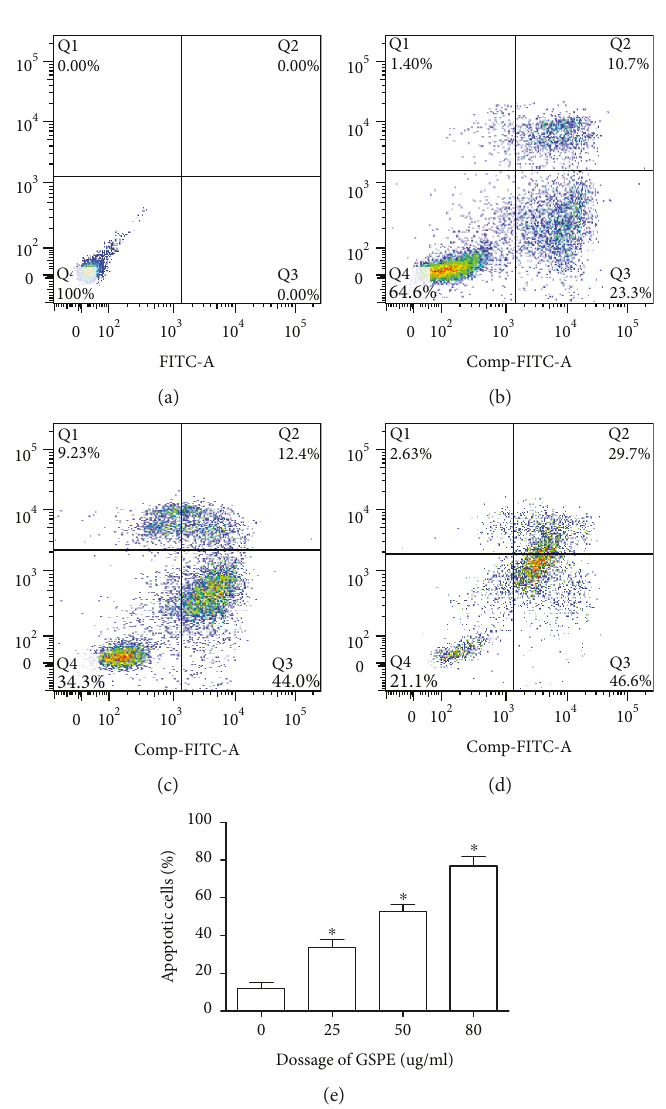
Figure 2: GSPE induced apoptosis of esophageal cancer cell ECA109 apoptosis. ECA 109 cells were treated with GSPE (0 – 80 μ g/mL) for 24h. Double staining with annexin V-FITC and PI was used to determine apoptosis. Values were mean ± SD of three independent samples. (a) GSPE 0 μ g/mL; (b) GSPE 25 μ g/mL; (c) GSPE 50 μ g/mL; (d) GSPE 80 μ g/mL; (e) GSPE 0 – 80 μ g/mL. ∗ P < 0 01 compared with the GSPE 0 μ g/mL